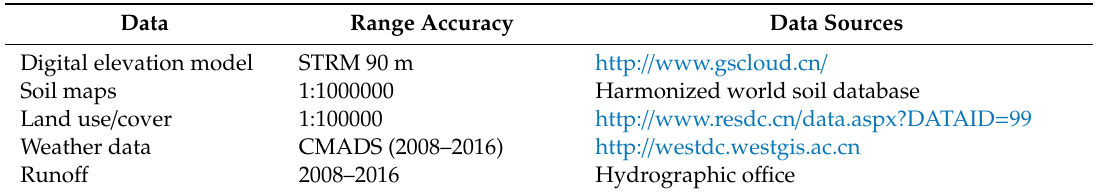
Table 2. Basic data for the